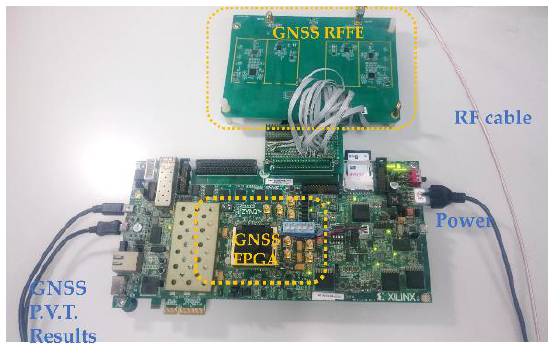
Figure 7. The implemented dual-frequency GNSS FPGA receiver.